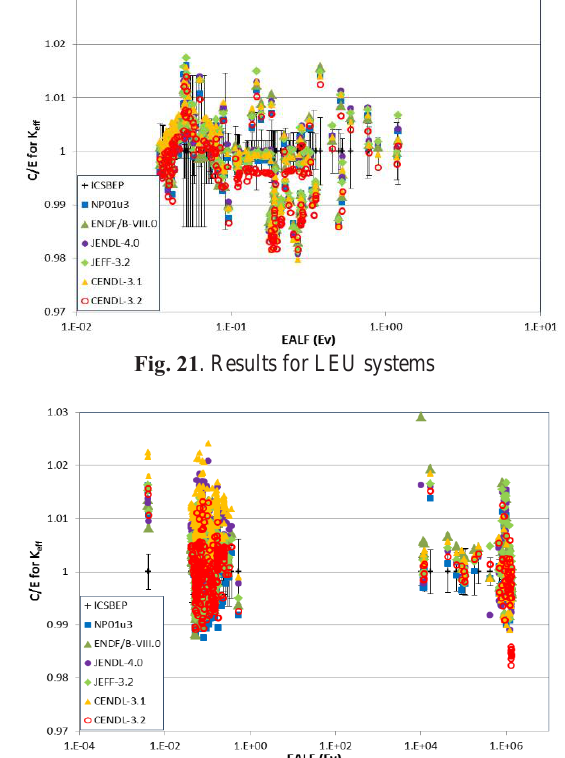
Fig. 20. Results for IEU systems